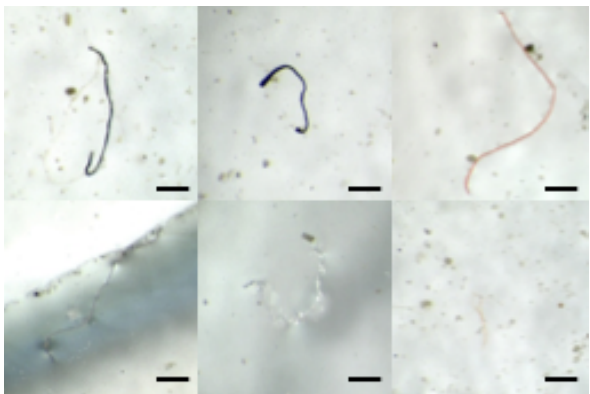
Figure 2. The range of color and size of microfibers detected in surface water samples from the three sites within Chichester Harbour (scale bars = 100